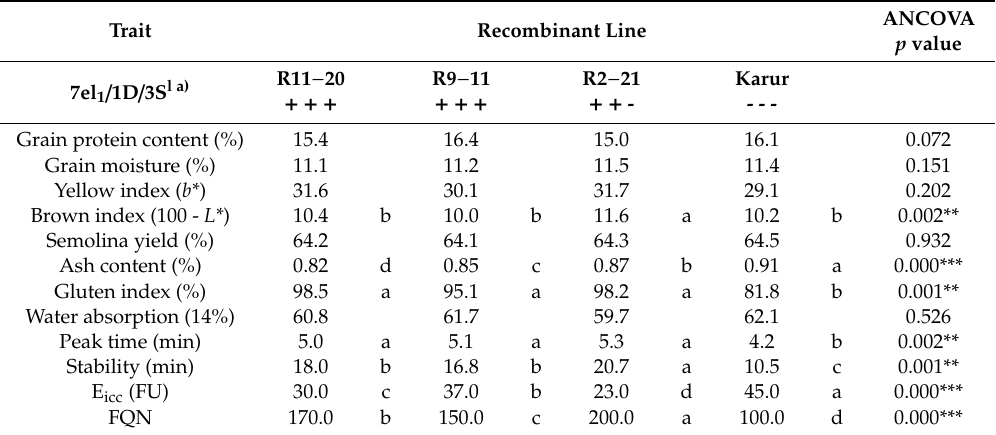
Table 6. Grain and semolina quality traits of the selected genotypes in the 2017 season. Trait Recombinant